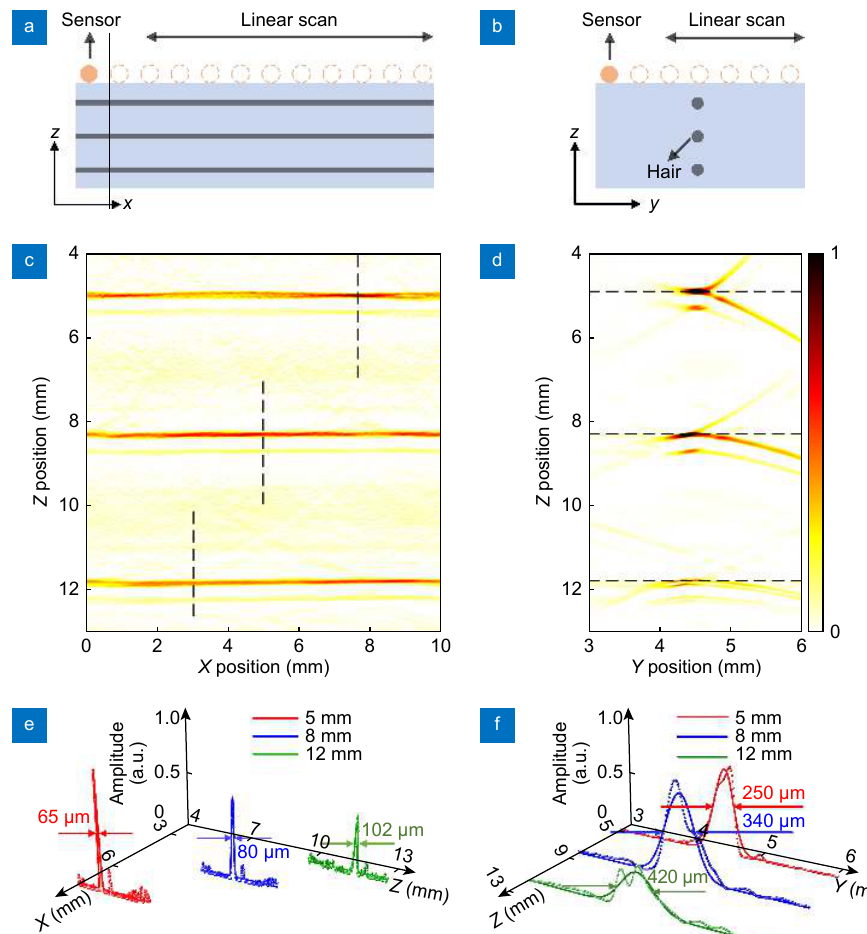
Fig. 7 | Images of three human hairs using the photoacoustic tomography system. ( a , b ) The sensor is placed perpendicular and parallel to hairs in the axial and lateral resolution measurements, respectively. ( c , d ) The reconstructed images of the hairs corresponding to (a) and (b), re- spectively. ( e , f ) The axial and lateral resolutions at different imaging